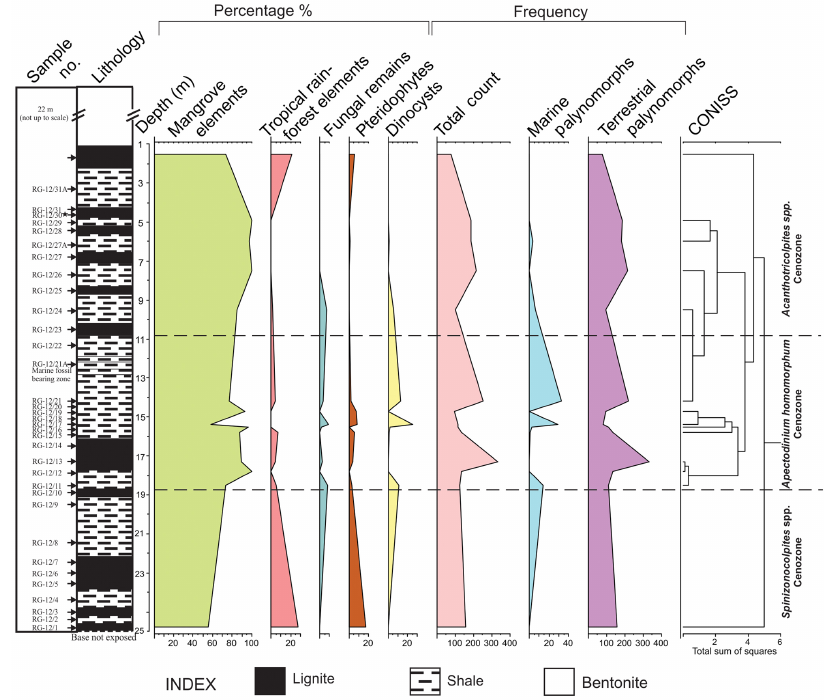
Figure 7. Distribution of a group of palynomorph taxa in the Giral lignite mine, Barmer Basin.